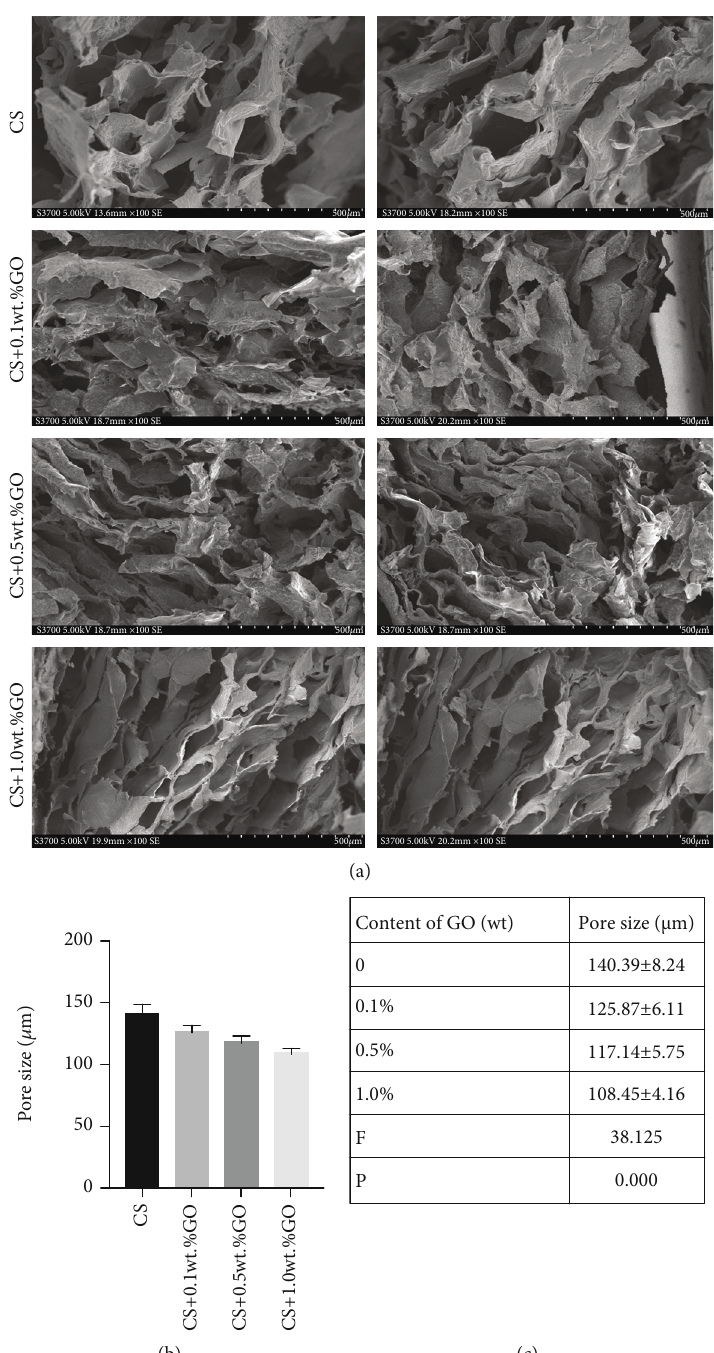
Figure 2: SEM images of the CS/GO hydrogel sca ff olds. (a) SEM image of the cross-section of the sca ff olds of each group ( bar = 500 μ m). (b, c) Aperture size of each group randomly measured by ImageJ. ∗ P < 0 : 05 compared with the cases of other